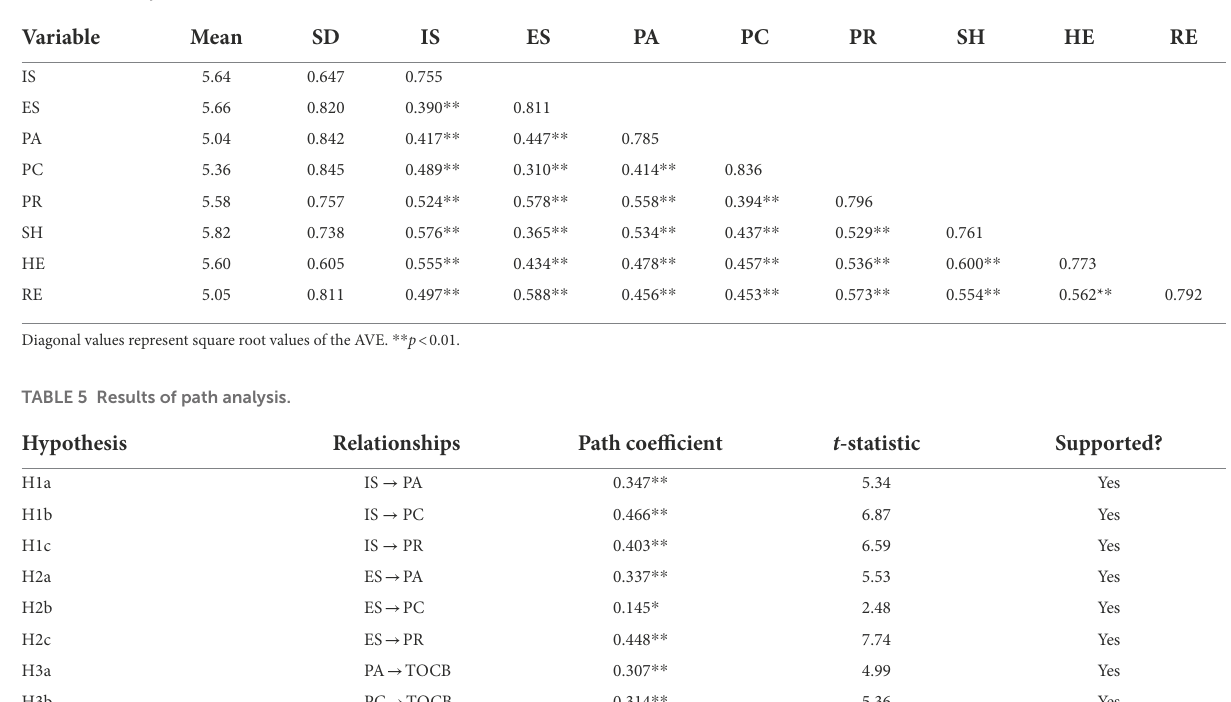
TABLE 4 Descriptive statistics and correlation estimates.